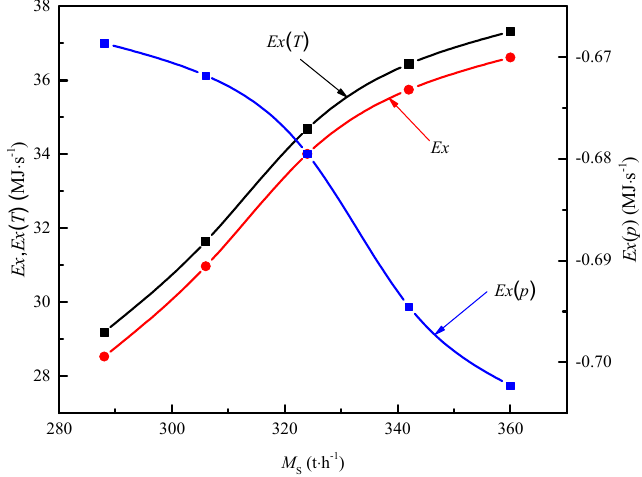
Figure 10. Effects of the sinter mass flow rate on enthalpy exergy Ex , temperature exergy Ex ( T ), and pressure exergy Ex ( p ).